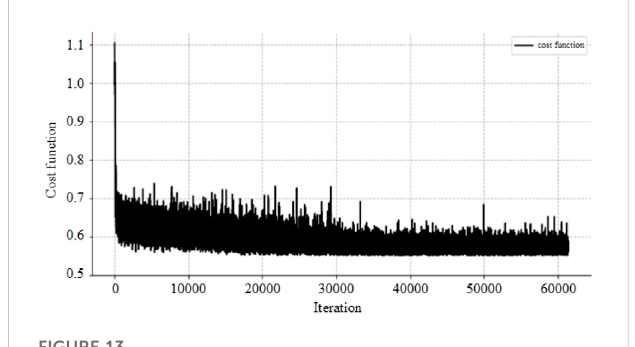
FIGURE 13 Cost function of SAE-dropout network.